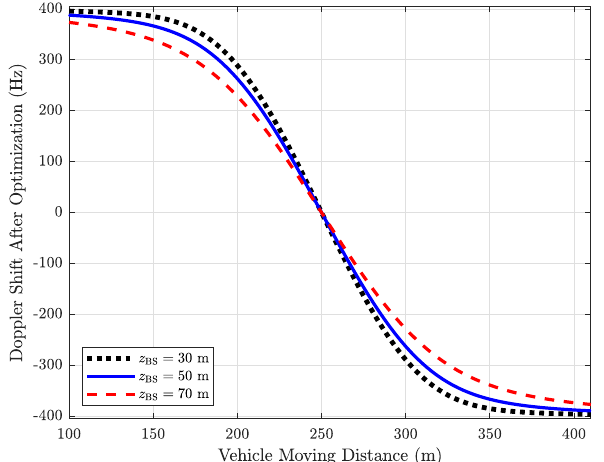
Figure 11. Optimized DS for different positions of the